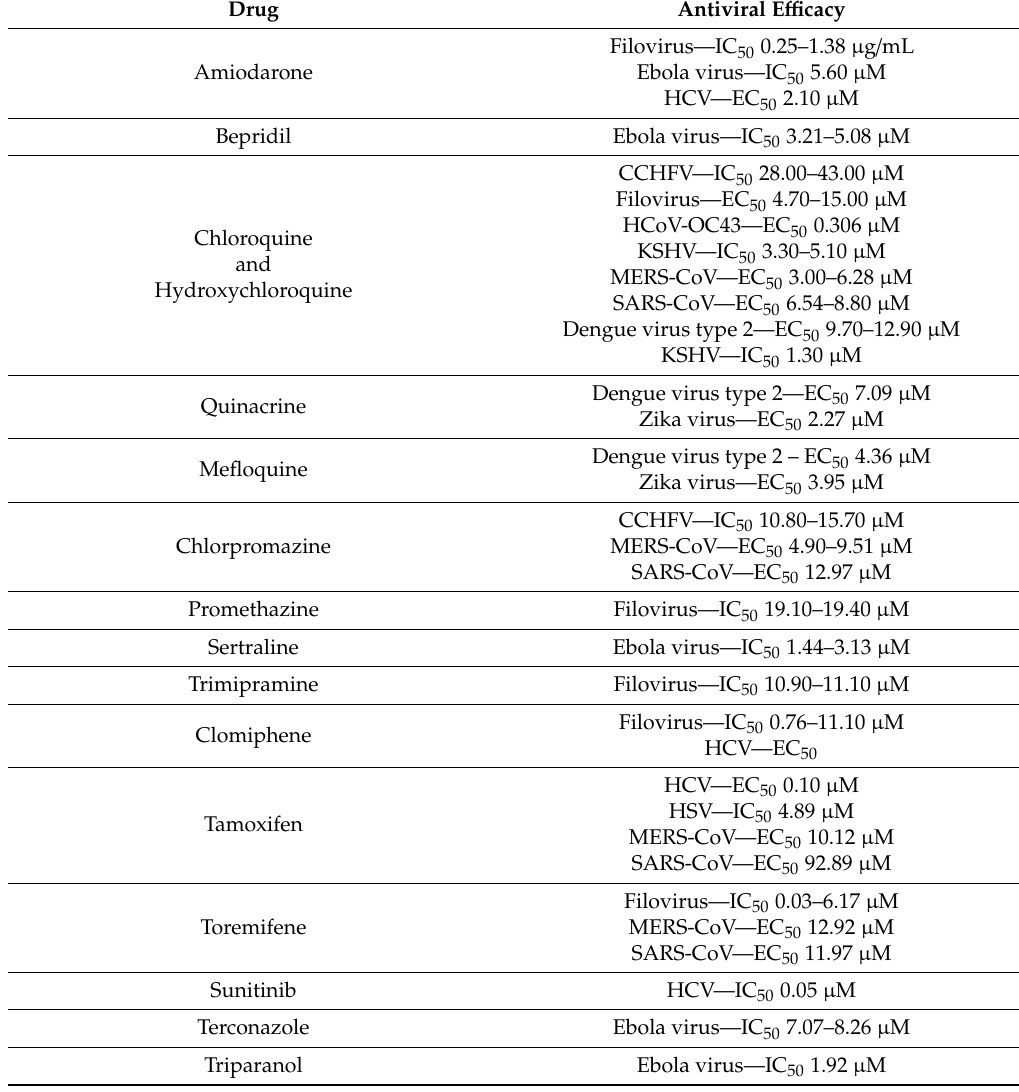
Table 2. Antiviral e ffi cacy of selected cationic amphiphilic drugs, adapted from Salata 2017